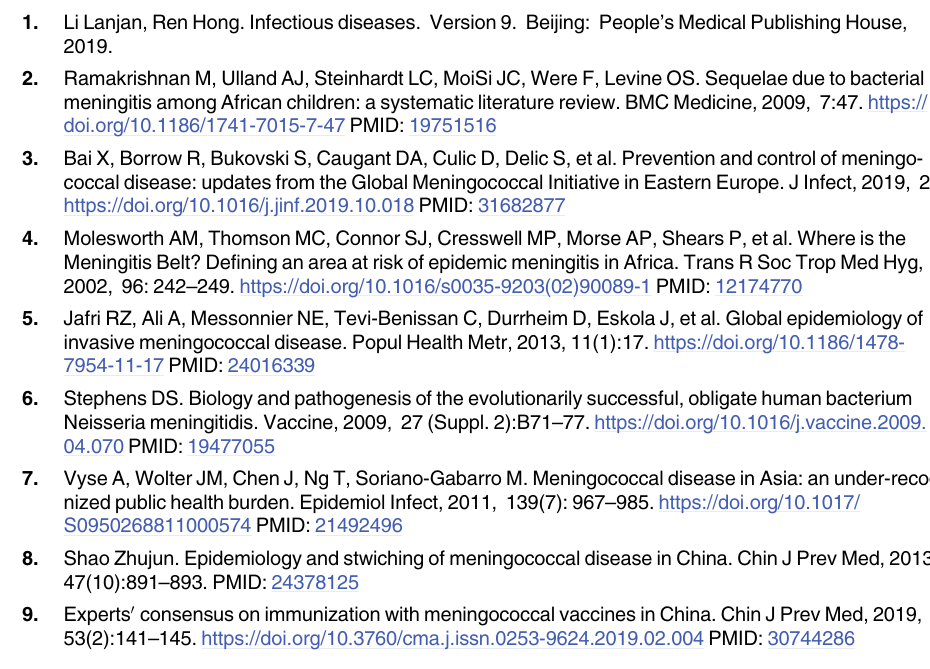
months of age and one dose of booster immunization at 3 and 6 years of age can produce high concentration of antibodies. S3 Table. Hangzhou’s per capita income over the years from 2016 to 2018. Hangzhou’s financial per capita income from 2016 to 2018 shows that the urban per capita income is much higher than the rural per capita income. The disposable income of rural people is much lower than that of urban